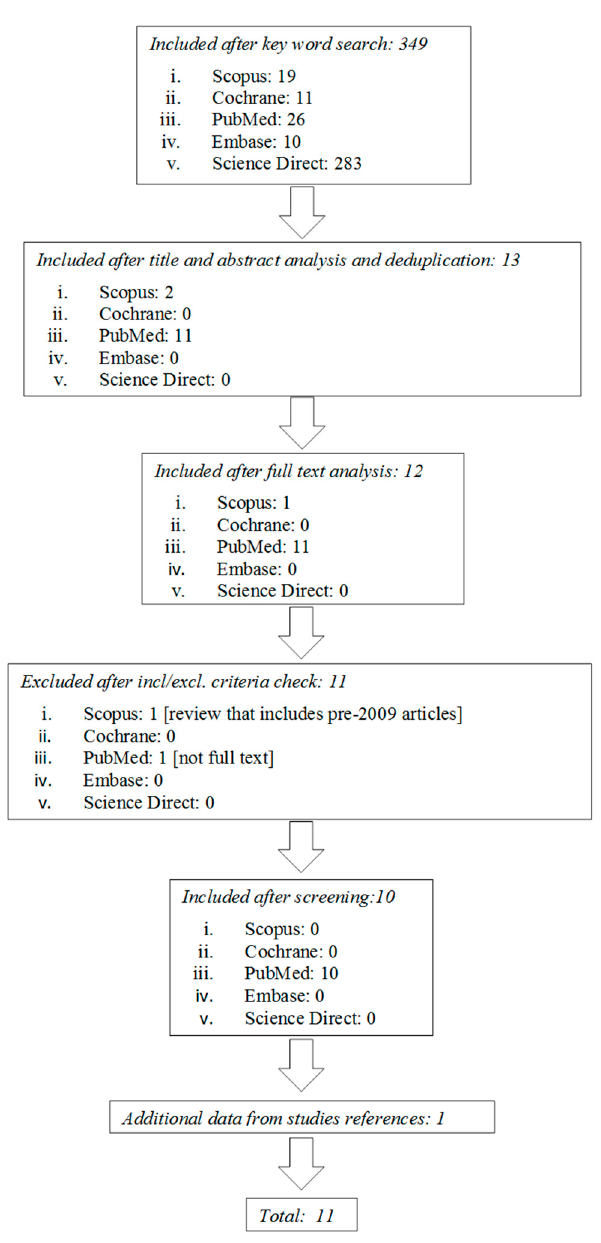
Figure 1. Flow diagram of the study selection process.